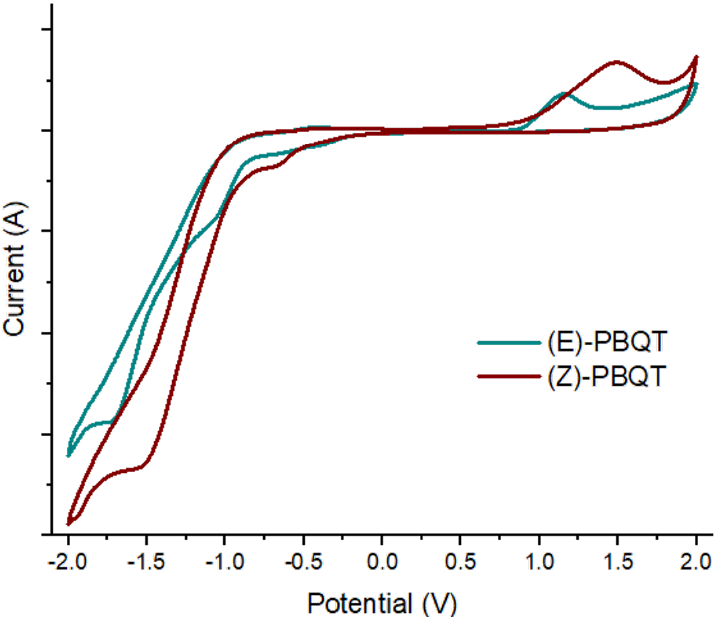
Figure 8. Voltammogram of (E)-PBQT in film vs. Ag/AgCl 2 , E onset (Ox) = 0.89 V, E onset (Red) = − 0.77 V, Egap E = 1.66 eV, and (Z)-PBQT in film vs. Ag/AgCl, E onset (Ox) = 0.89 V, E onset (Red) = − 0.71 V, Egap E = 1.60 Ev. Table 4. Electrochemical properties of PBQT .